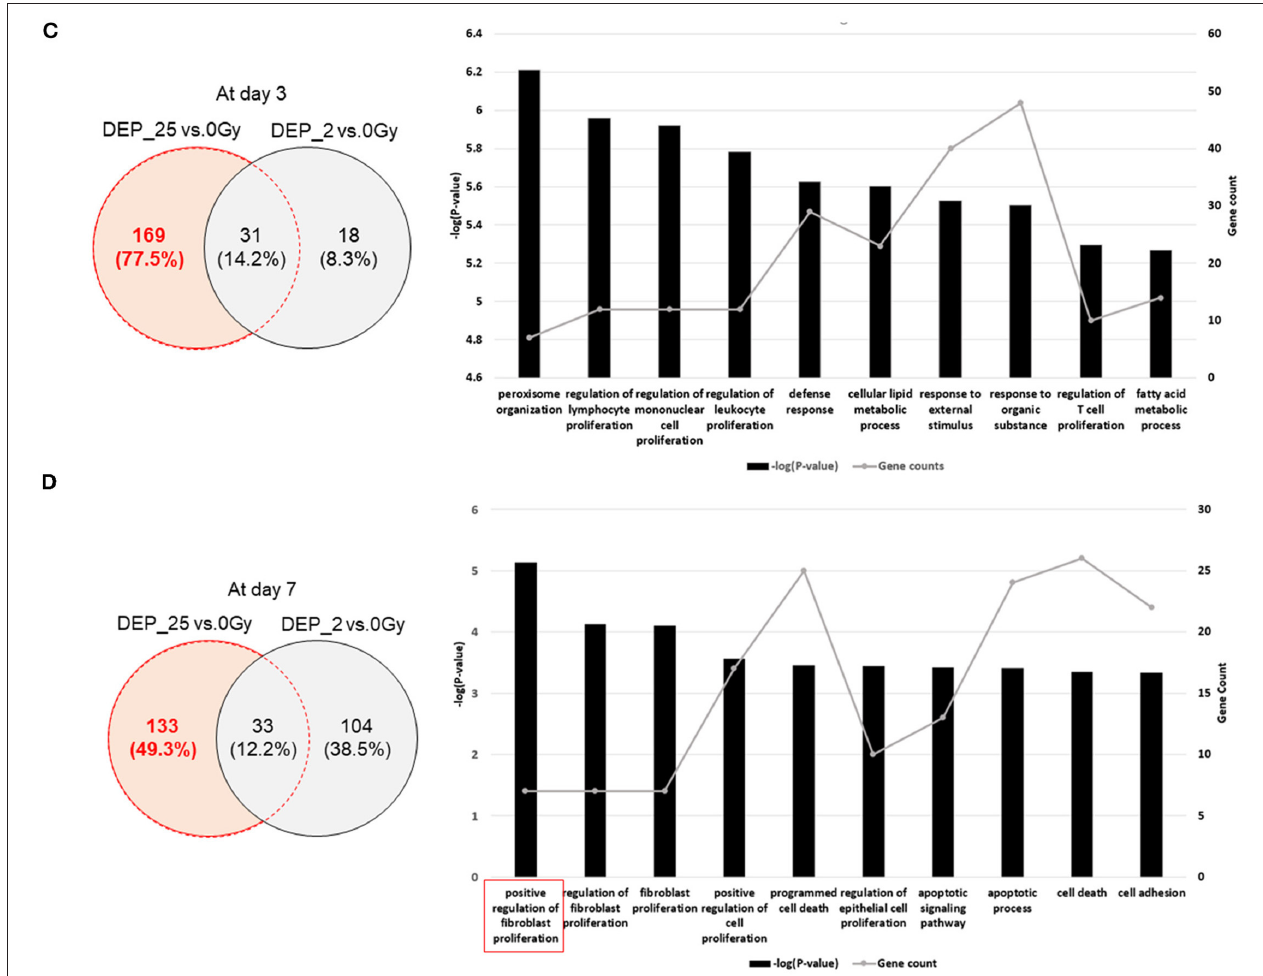
FIGURE 4 | Protein expression comparison based on t -test between each different dose group and biological process of specifically expressed proteins at 25Gy irradiation. (A) The hierarchical clustering of DEPs after t -test comparison between each group individually at day 3. The colorimetric scheme represented z-normalized intensity of DEPs. 49 DEPs between 0 and 2Gy, 200 DEPs between 0 and 25Gy, and 46 DEPs between 2 and 25Gy. (B) The hierarchical clustering of DEPs after t -test comparison between each group individually at day 7. The colorimetric scheme represented z-normalized intensity of DEPs. 137 DEPs between 0 and 2Gy, 166 DEPs between 0 and 25Gy, and 68 DEPs between 2 and 25Gy. (C) The 169 specifically expressed proteins at 25Gy at day 3, determined by excluding DEPs between 0 and 25Gy from DEPs between 0 and 25Gy. The biological process of those were filtered with P -value lower than 0.05. The bar chart represent − ( P − value ) and spotted plot represent the number of proteins included in specific process. (D) The 133 specifically expressed proteins at 25Gy at day 7, determined by excluding DEPs between 0 and 25Gy from DEPs between 0 and 25Gy. The biological process of those were filtered with P -value lower than 0.05. The bar chart represent − ( P − value ) and spotted plot represent the number of proteins included in specific